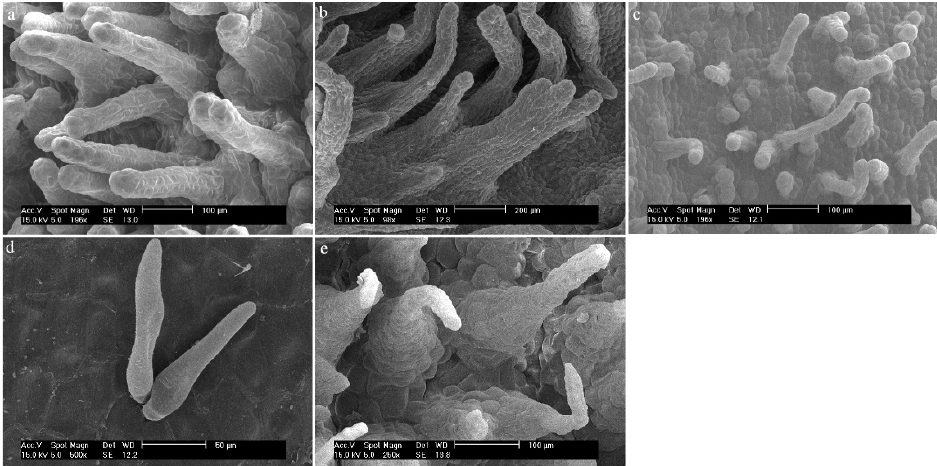
Figure 2. The types of trichomes found on the labellum of the Dendrobium species: ( a ) cylindrical; ( b ) cylindrical and branched; ( c ) cylindrical with a bulbous cell at the apex; ( d ) ellipsoidal; ( e ) conical.